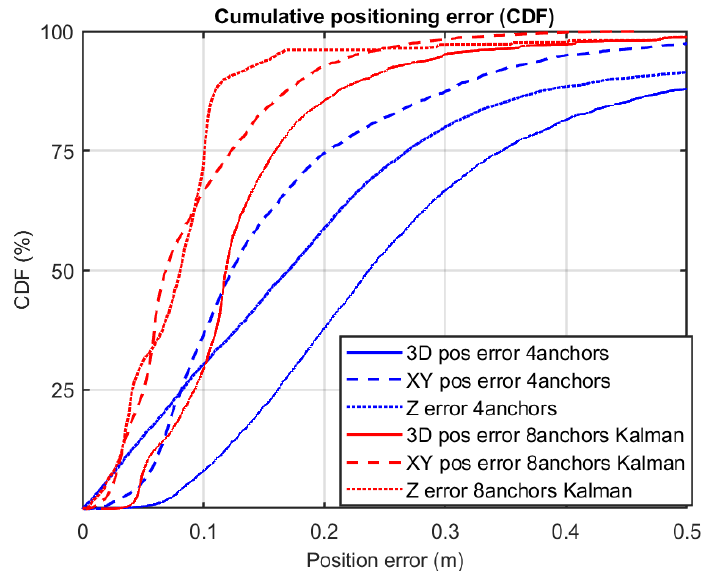
Figure 15. Location error in CDF (Cumulative Distribution Function), in the case of using four ranges (algorithm integrated in the tags by the manufacturer Decawave), and in the case of using eight ranges with an external algorithm based on the Kalman